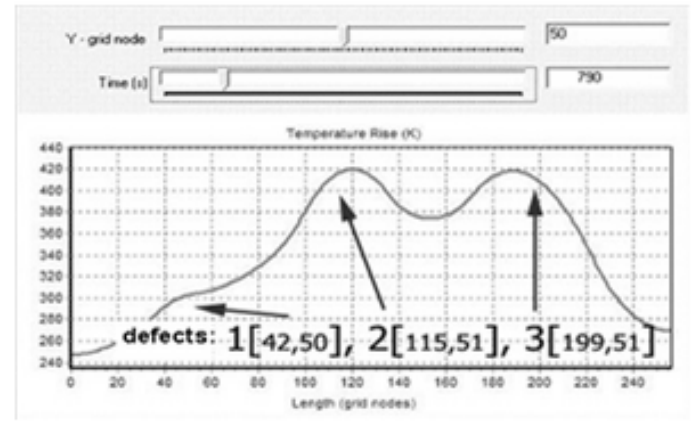
Figure 4. 3 Defects spatial profile.